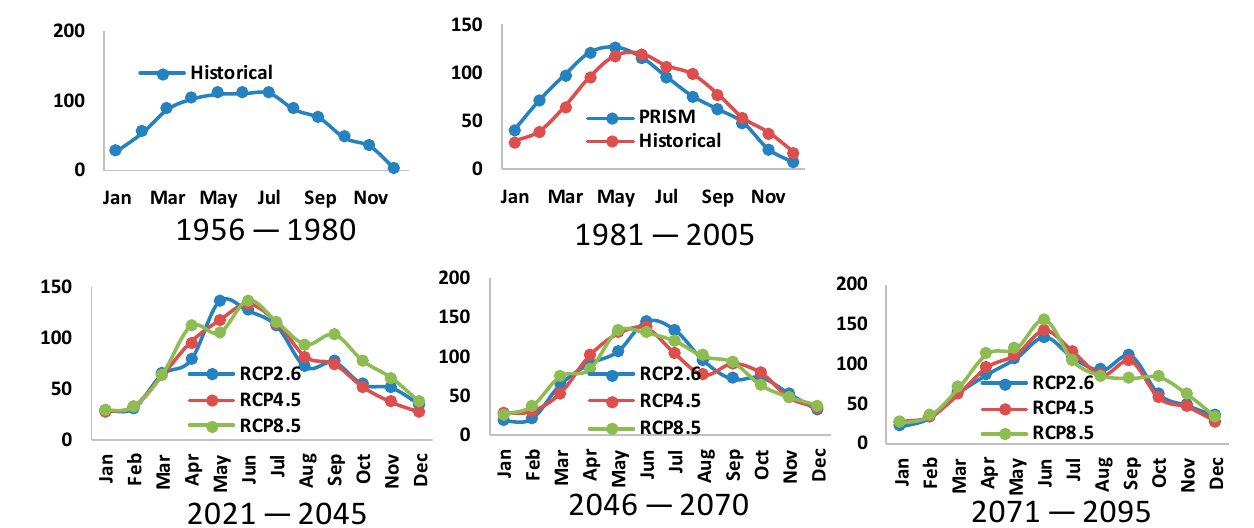
Figure 2. Trends in monthly average maximum temperature (°C) patterns for each climate scenario.